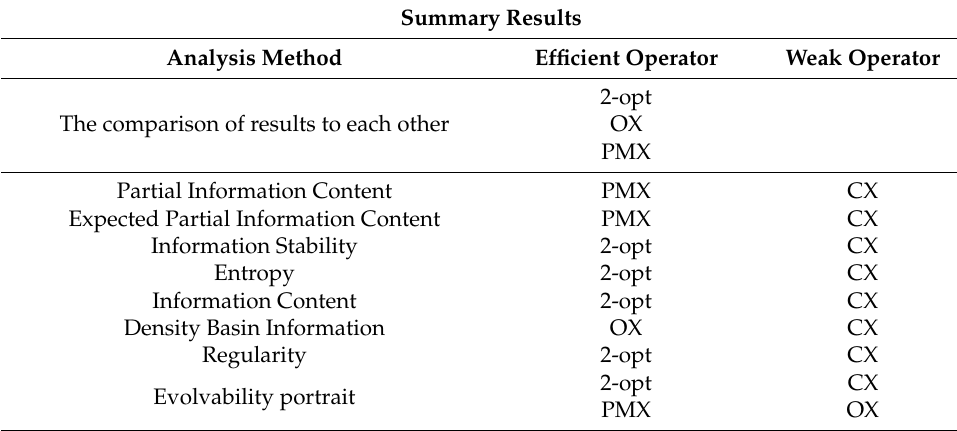
Table 6. Summary results: basin of attraction map with random walk